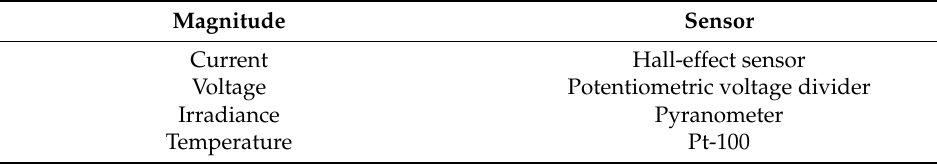
Figure 2. Communications diagram of the I ‐ V curve tracer.